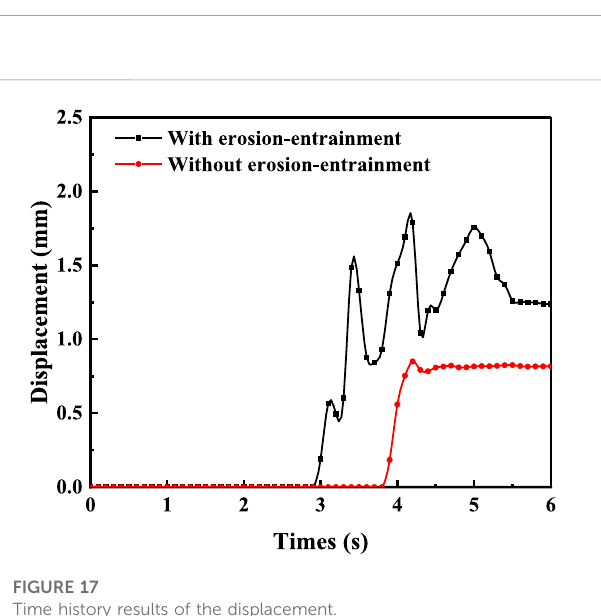
FIGURE 16 Time history results of the impact force.